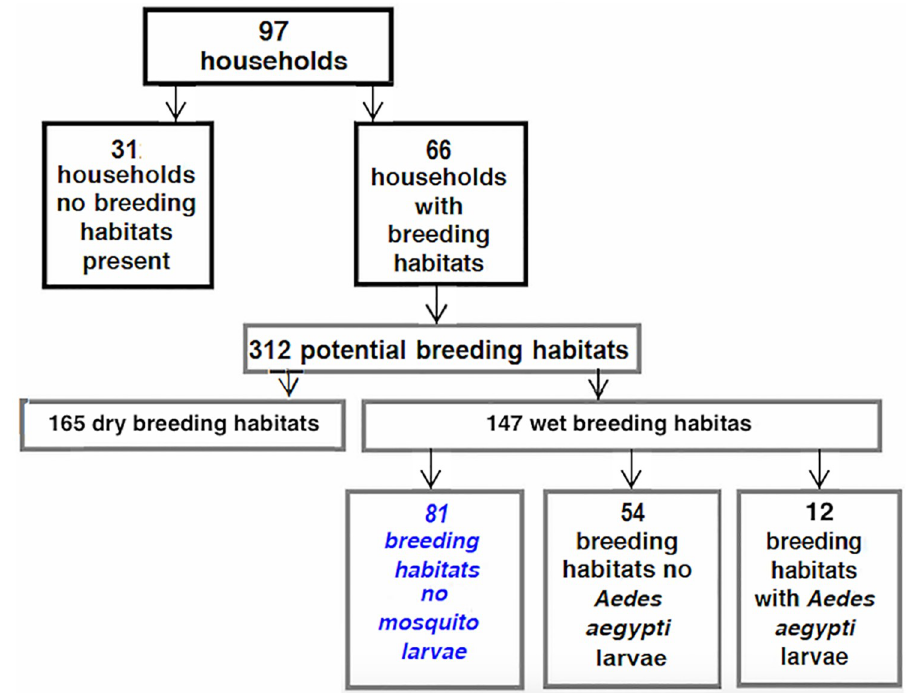
Fig 5. Distributions of PBHs across households and productive breeding